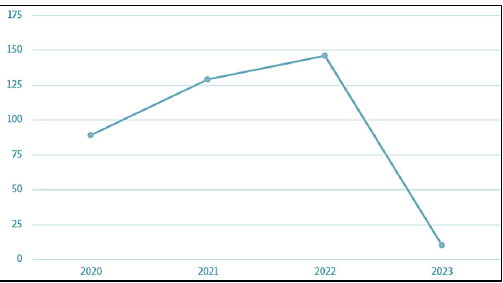
Fig. 6. Countries that published related to the words Clean energy” and “Sea